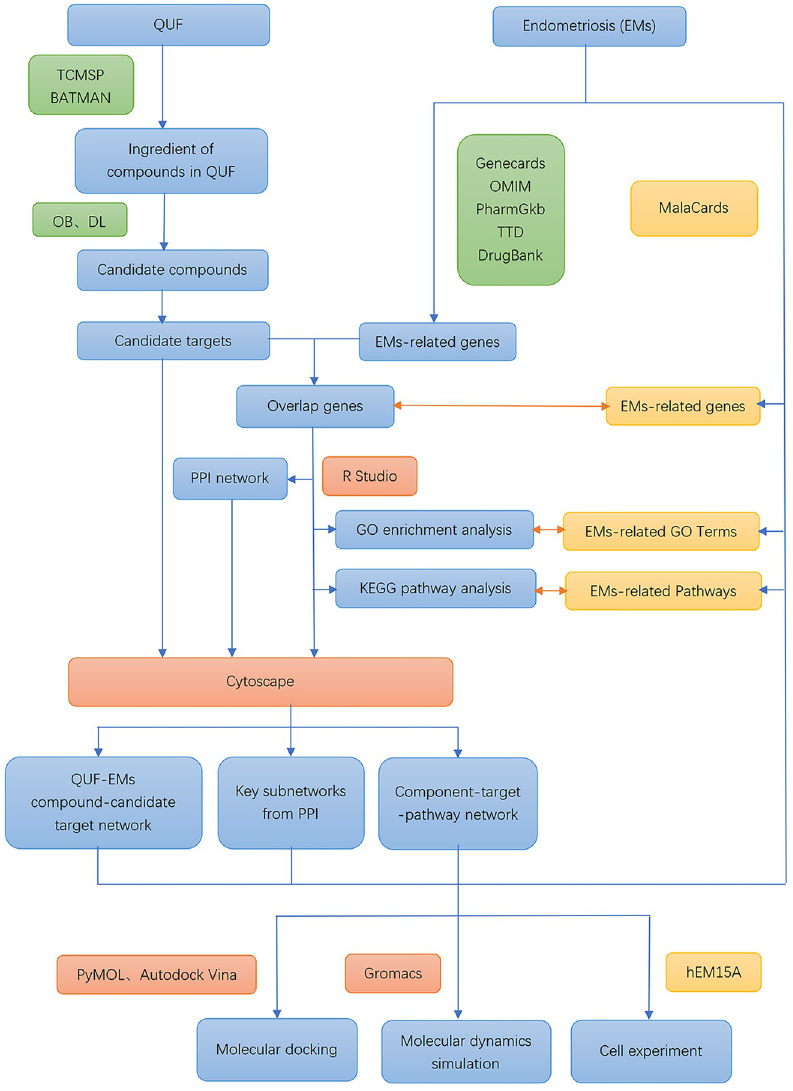
Fig 1. Workflow for Qu’s formula (QUF) against endometriosis. Abbreviations: QUF: Qu’s formula; TCMSP: Traditional Chinese Medicine Systems Pharmacology; BATMAN: Bioinformatics Analysis Tool for Molecular Mechanism; OB: Oral Bioavailability; DL: Drug-Like; EMs: Endometriosis; PPI: Protein–Protein Interaction.